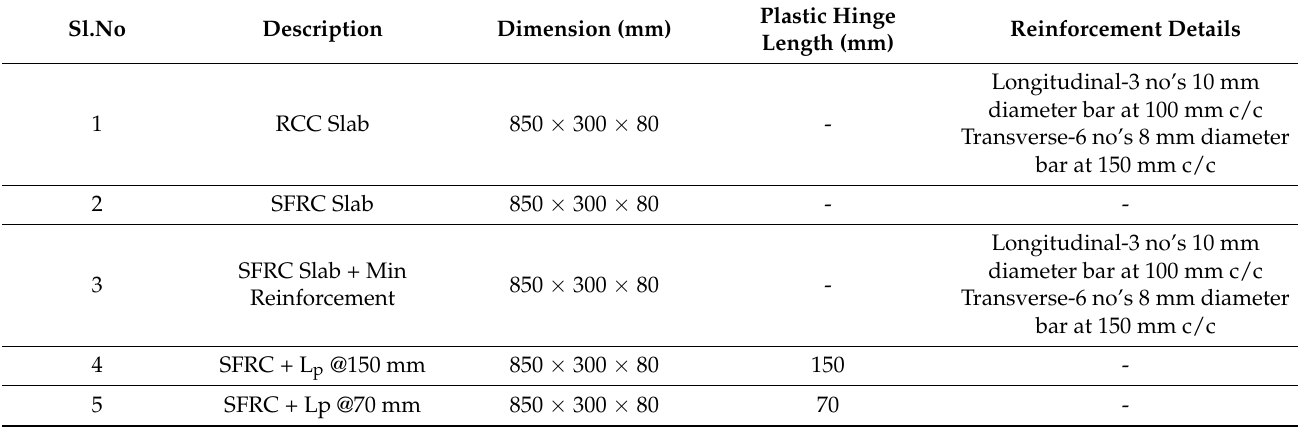
Table 4. Dimensions and specifications of